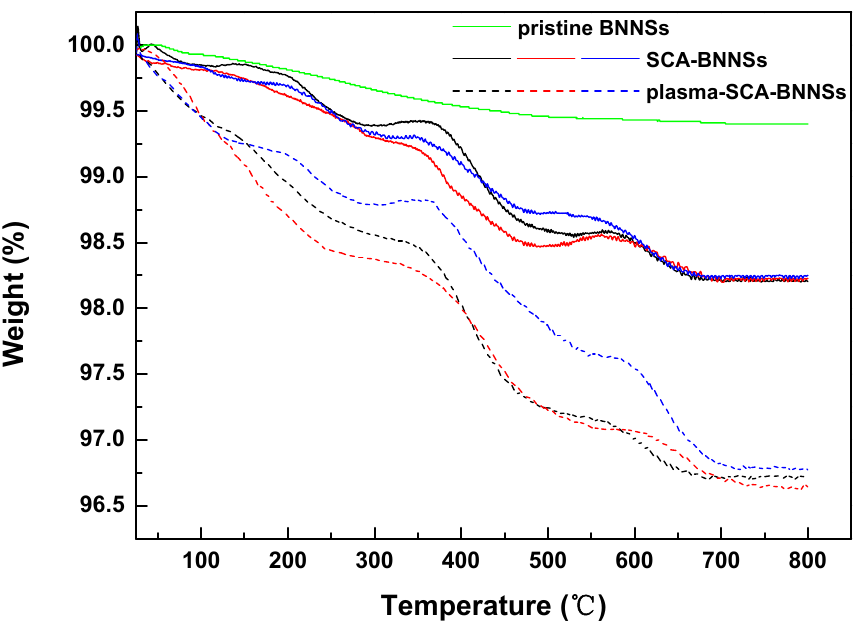
Figure 10. Thermal degradation of pristine BNNSs, SCA treated BNNSs (SCA ‐ BNNSs), and plasma and SCA treated BNNSs (plasma ‐ SCA ‐ BNNSs). The interval between each treatment and test is less than 1 h. Table 1. Coating rate of SCA treated BNNSs (SCA ‐ BNNSs), and plasma and SCA treated BNNSs (plasma ‐ SCA ‐ BNNSs).